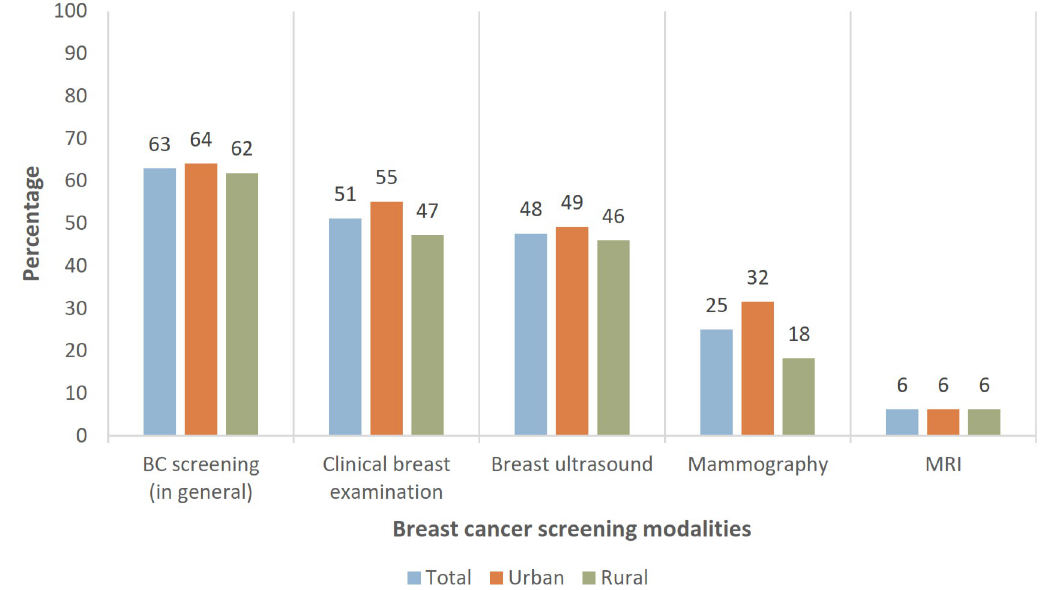
Fig 1. Respondents who had been screened for breast cancer (any modality) by